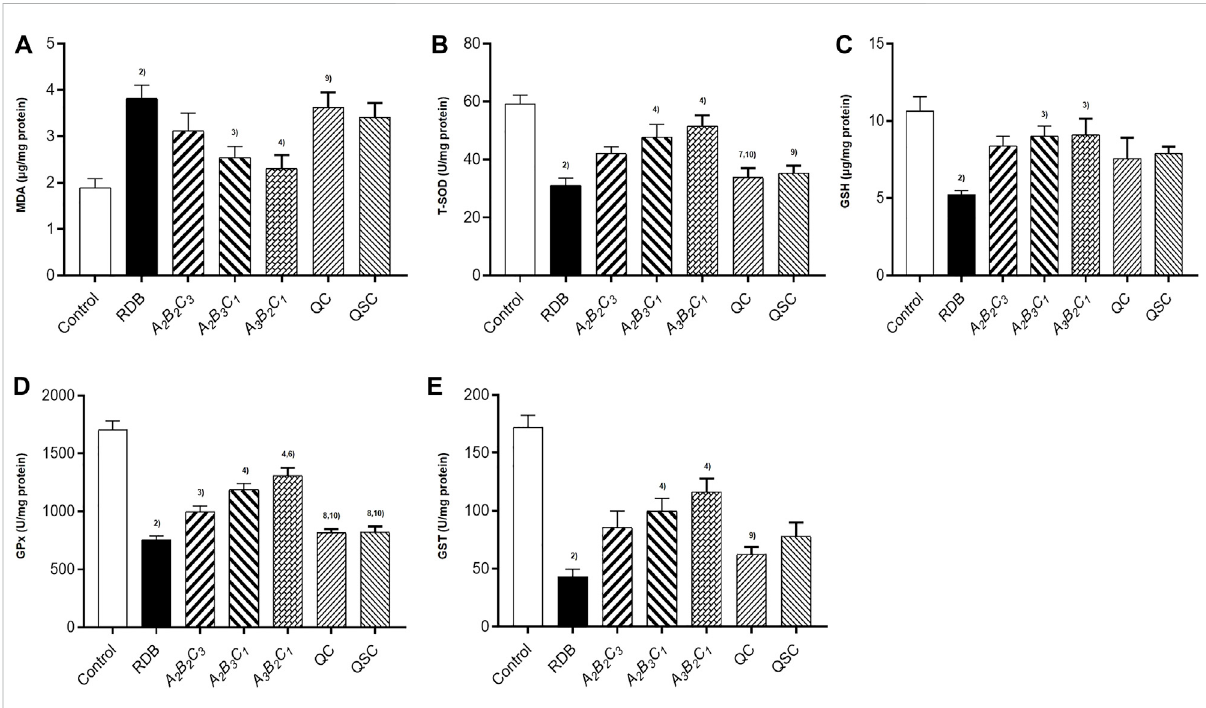
FIGURE 5 Processing with ASR ameliorated hepatic oxidative stress induced by RDB in mice. (A) Hepatic MDA levels. (B) Hepatic T-SOD activity. (C) Hepatic GSH levels. (D) Hepatic GPx activity. (E) Hepatic GST activity. Data were expressed as mean ± S.E.M., with 10 mice in each group. 1) p < 0.05, 2) p < 0.01, compared with the Control group, 3) p < 0.05, 4) p < 0.01, compared with the RDB group, 5) p < 0.05, 6) p < 0.01, compared with the